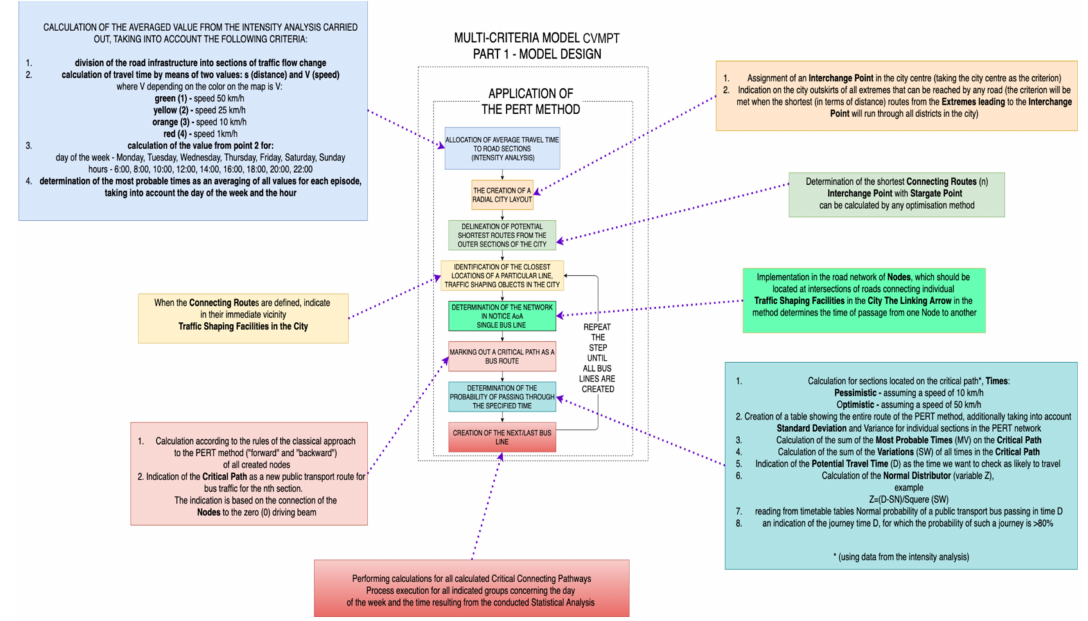
Figure 2. The multi-criteria model CVMPT—Part 1—the model design.